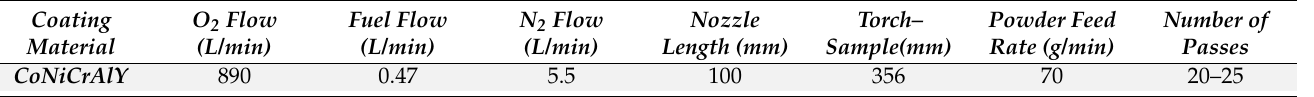
Table 2. Process parameters for coating fabrication on mild steel